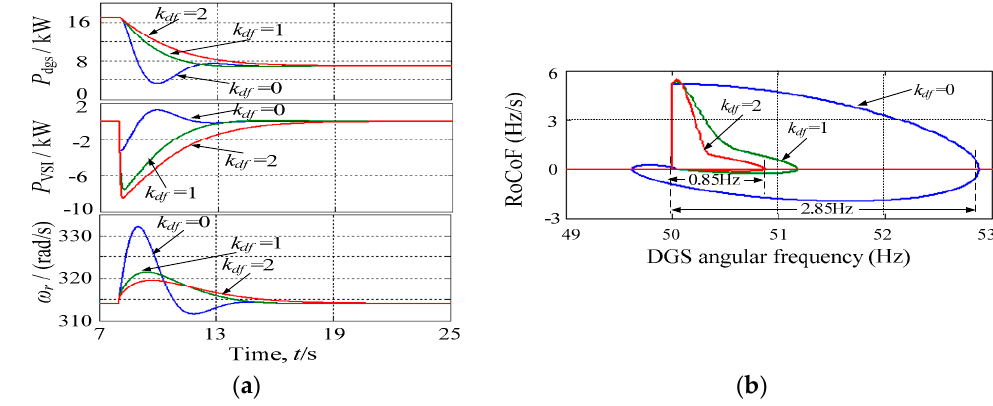
Figure 9. ( a ) Effects of the different differential feedforward gains ( D = 0. and J = 0.32 kg·m 2 ) on an active power transient; ( b ) Angular frequency-acceleration curves of DGS with differential feedforward control loop.